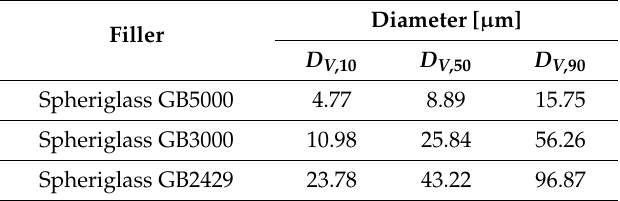
Table 3. Summary of the particle distribution of used